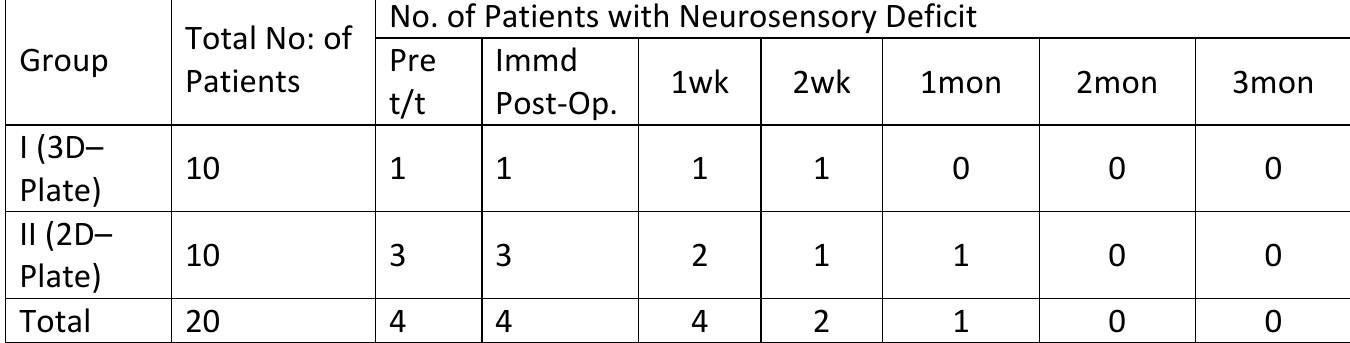
Table 4: Number of patients with Neurosensory